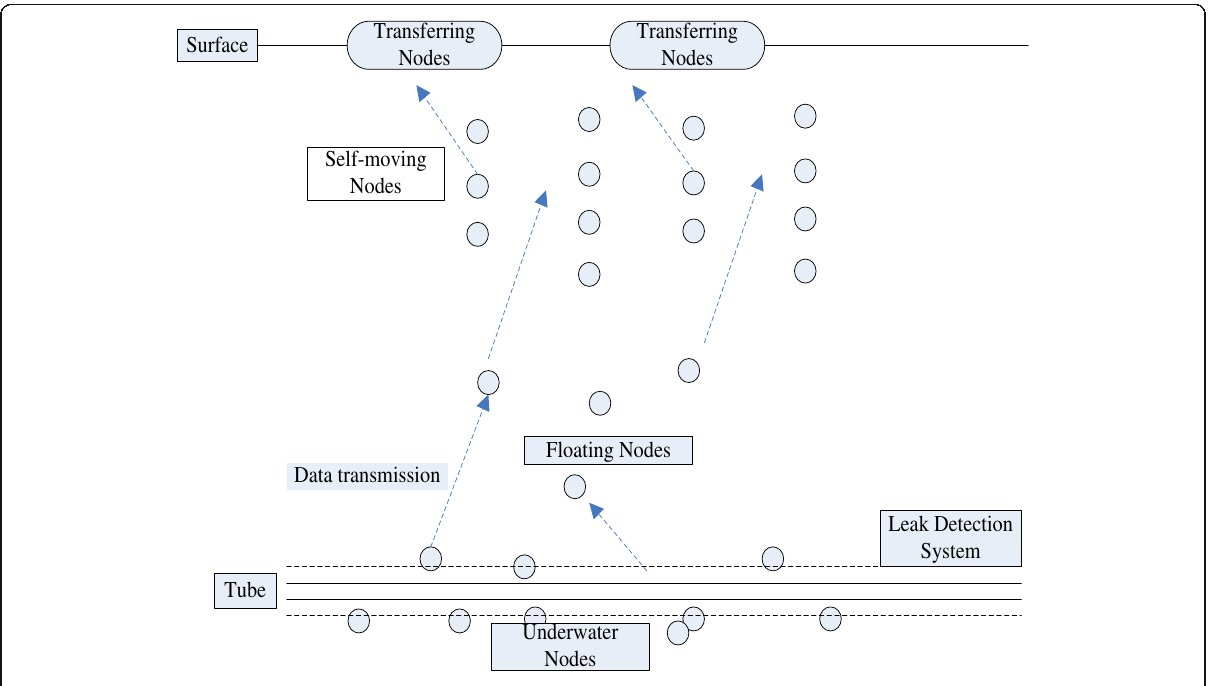
1. Physical layer In the leak detection system, the negative pressure wave method, pressure gradient method, and other methods com- bined with the leak detection and positioning technology will be utilized to monitor the real-time data of pipeline. Once